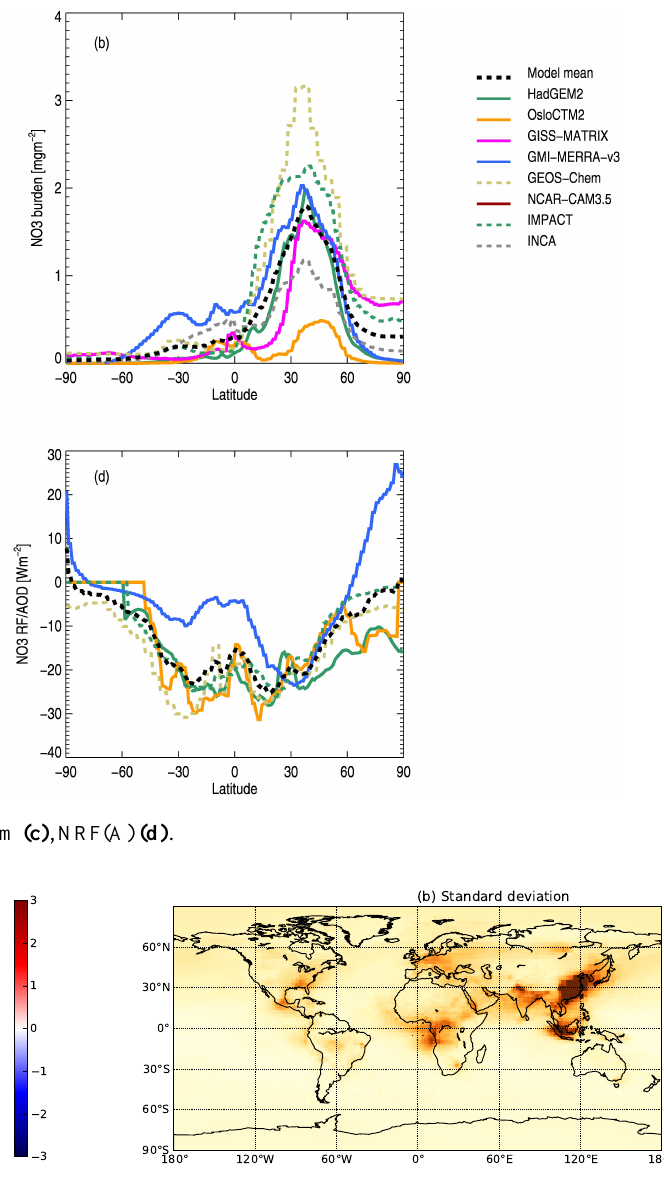
Fig. 13. Model mean RF (left) and standard deviation